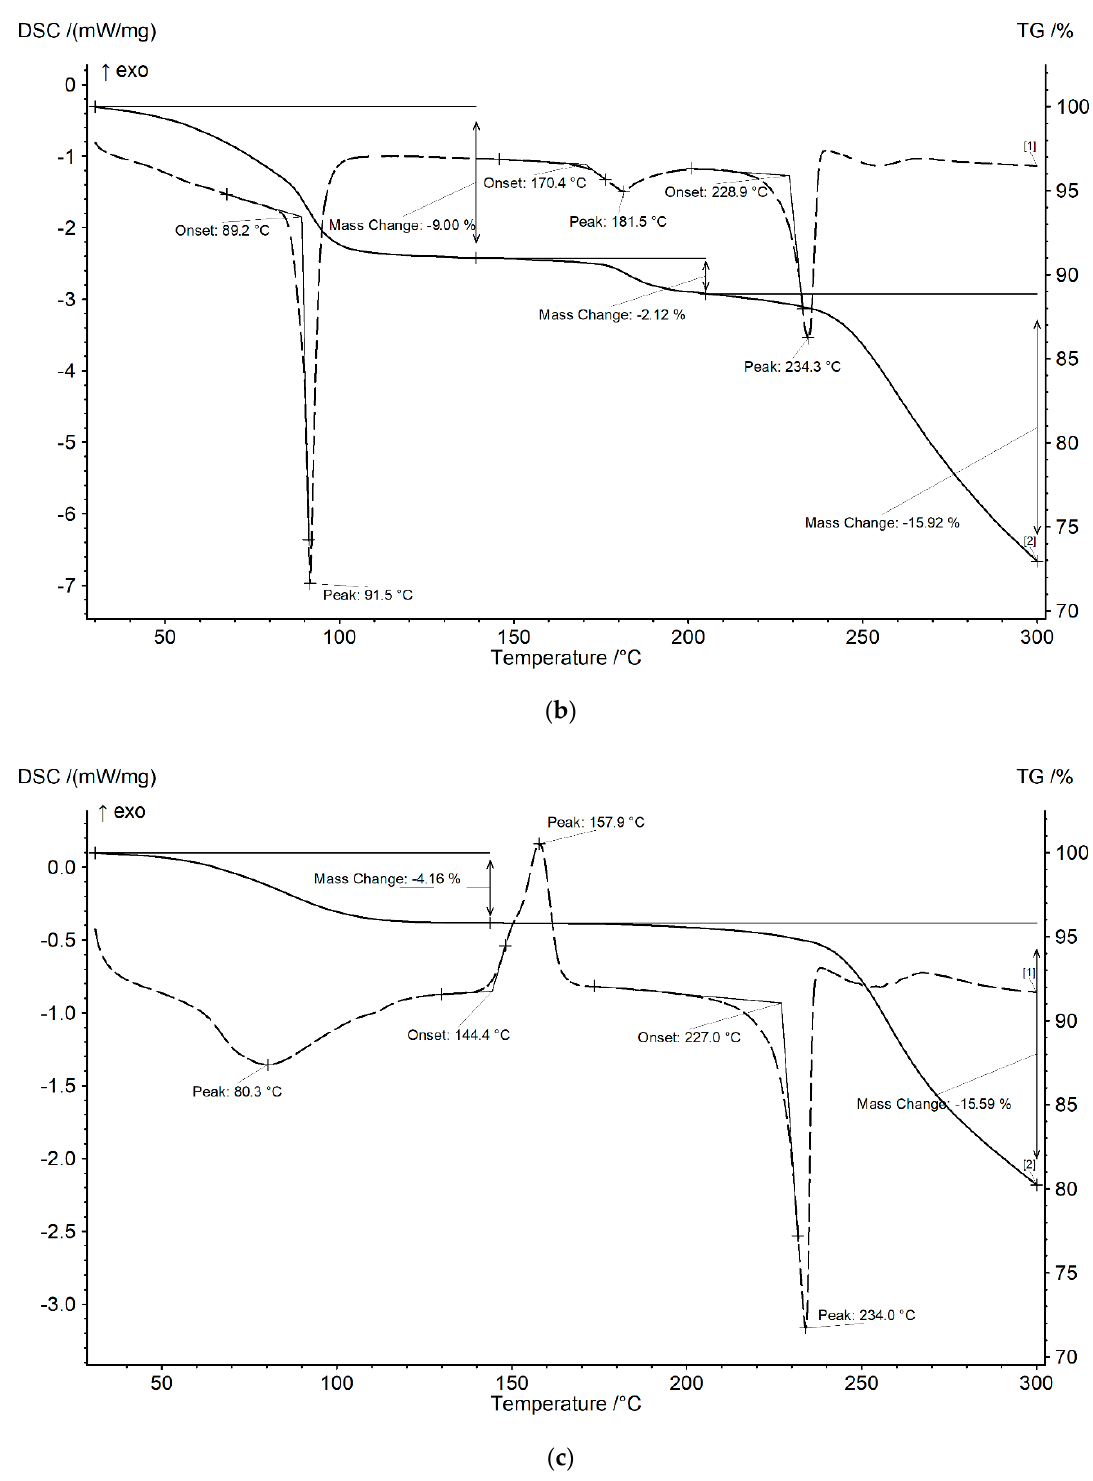
Figure 4. Thermograms of different taxifolin forms: ( a ) raw taxifolin; ( b ) taxifolin microtubes; ( c ) taxifolin microspheres.